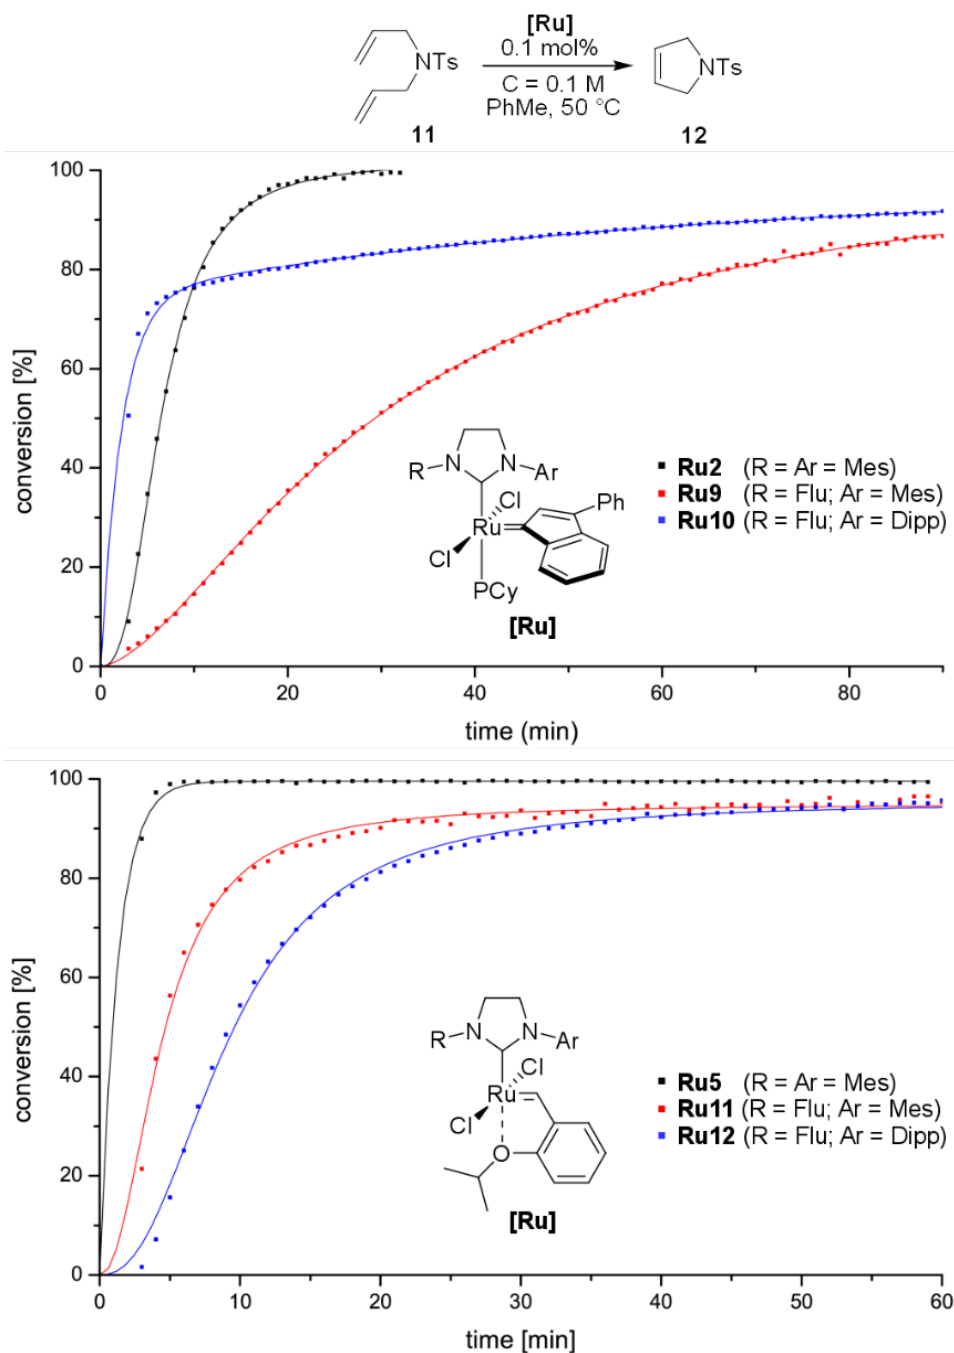
Figure 5. Time-conversion curves for ring-closing metathesis (RCM) of 11 . Flu = fluoren-9-yl. Lines are as a visual aid only.